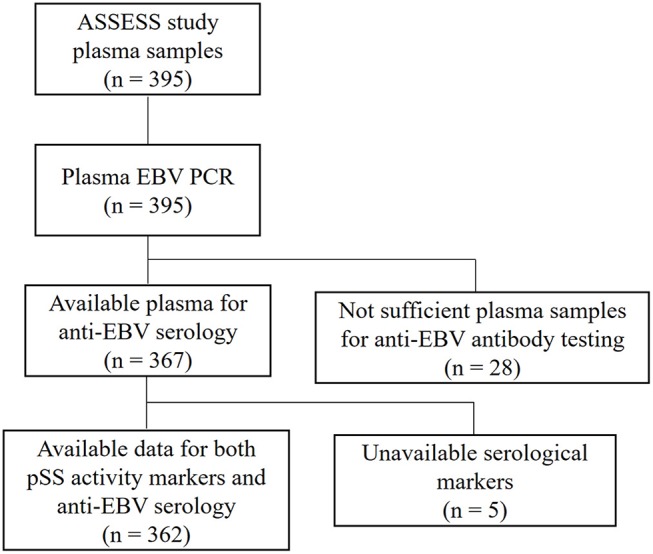
Schematic representation of evaluation of EBV infection in ASSESS cohort. Plasma samples from ASSESS cohort of pSS patients were initially evaluated for cell-free EBV DNA. After molecular testing the available plasma underwent to serological assessment of anti-EBV antibodies. Results were analyzed in comparison with pSS activity markers. ASSESS, the Assessment of Systemic Signs and Evolution in Sjögren's syndrome; pSS, primary Sjögren's syndrome.